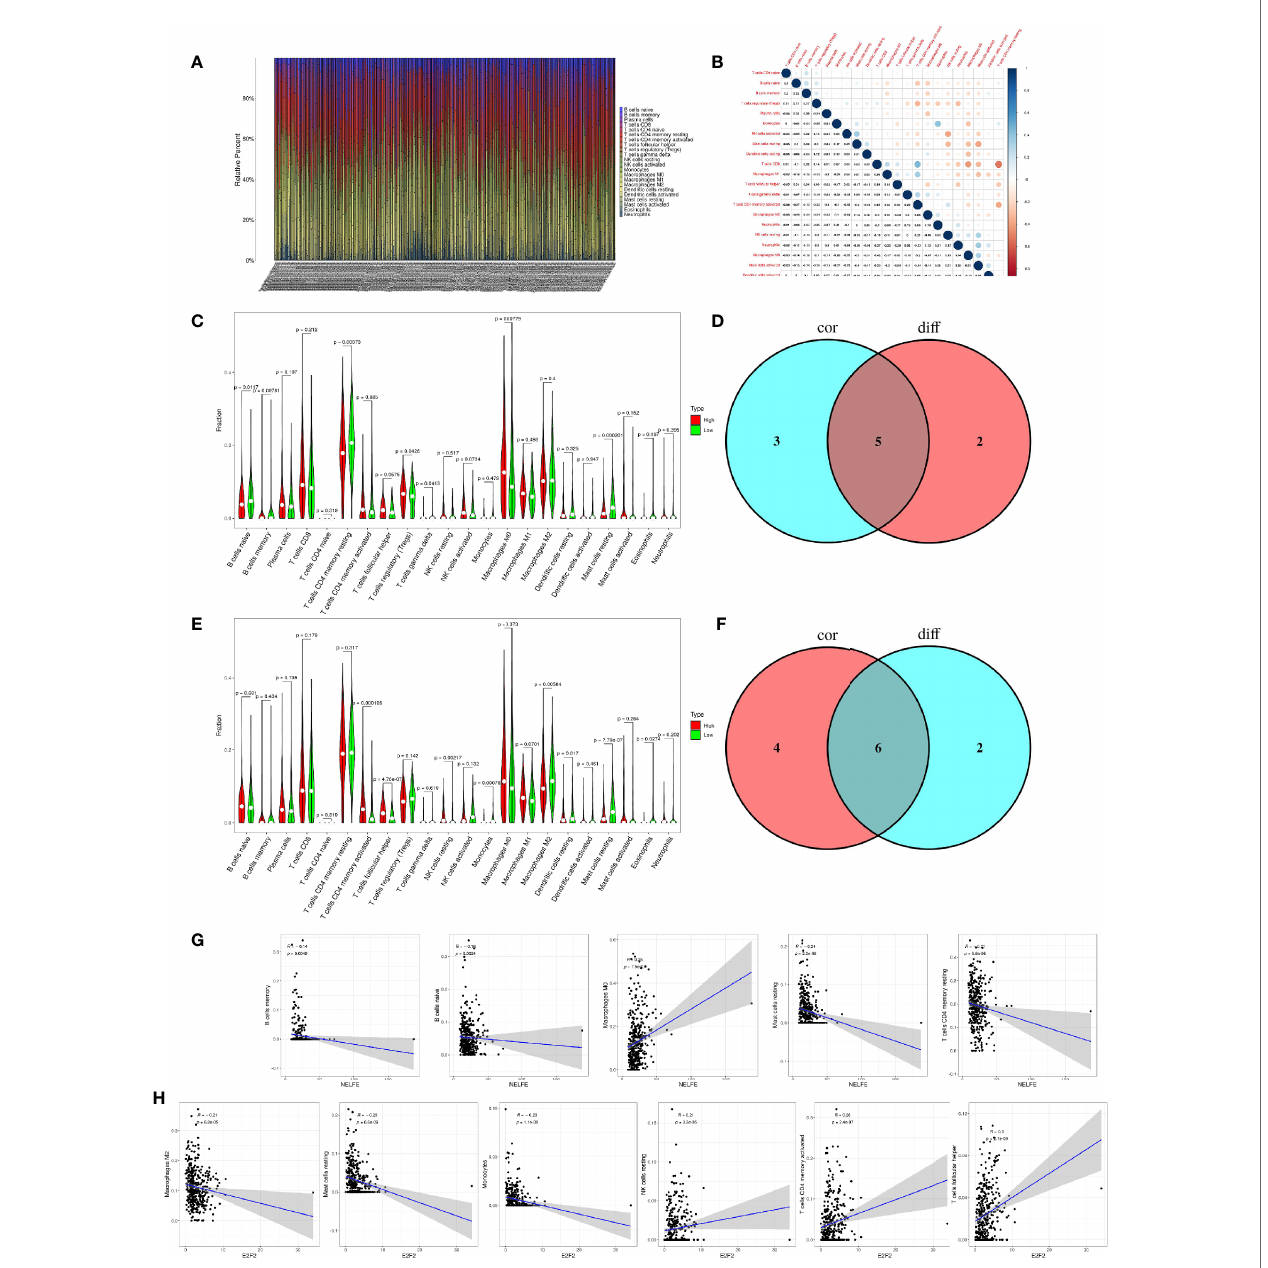
FIGURE 8 | Correlation of NELFE and E2F2 with the proportion of TICs. TIC pro fi le in tumor samples and correlation analysis. (A) Barplot showing the proportion of 22 kinds of TICs in gastric cancer samples. The column names in the plot are sample ID. (B) Heatmap showing the correlation between 22 kinds of TICs and numeric cells in each small box indicating the p value of the correlation between two kinds of cells. The shade of each small color box represents the corresponding correlation value between two cells, and the Pearson coef fi cient was used for the signi fi cance test. (C) Violin plot showing the ratio differentiation of 22 kinds of immune cells between gastric cancer samples with low or high NELFE expression relative to the median NELFE expression level, and Wilcoxon rank sum was used for the signi fi cance test. (D) Venn plot displaying fi ve kinds of TICs correlated with NELFE expression codetermined by difference and correlation tests displayed in violin and scatter plots, respectively. (E) Violin plot showing the ratio differentiation of 22 kinds of immune cells between gastric cancer samples with low or high E2F2 expression relative to the median E2F2 expression level, and Wilcoxon rank sum was used for the signi fi cance test. (F) Venn plot displaying six kinds of TICs correlated with E2F2 expression codetermined by difference and correlation tests displayed in violin and scatter plots, respectively. (G, H) Scatter plot showing the correlation of the proportions of 5 kinds of TICs with NELFE expression and the proportions of 6 kinds of TICs with E2F2